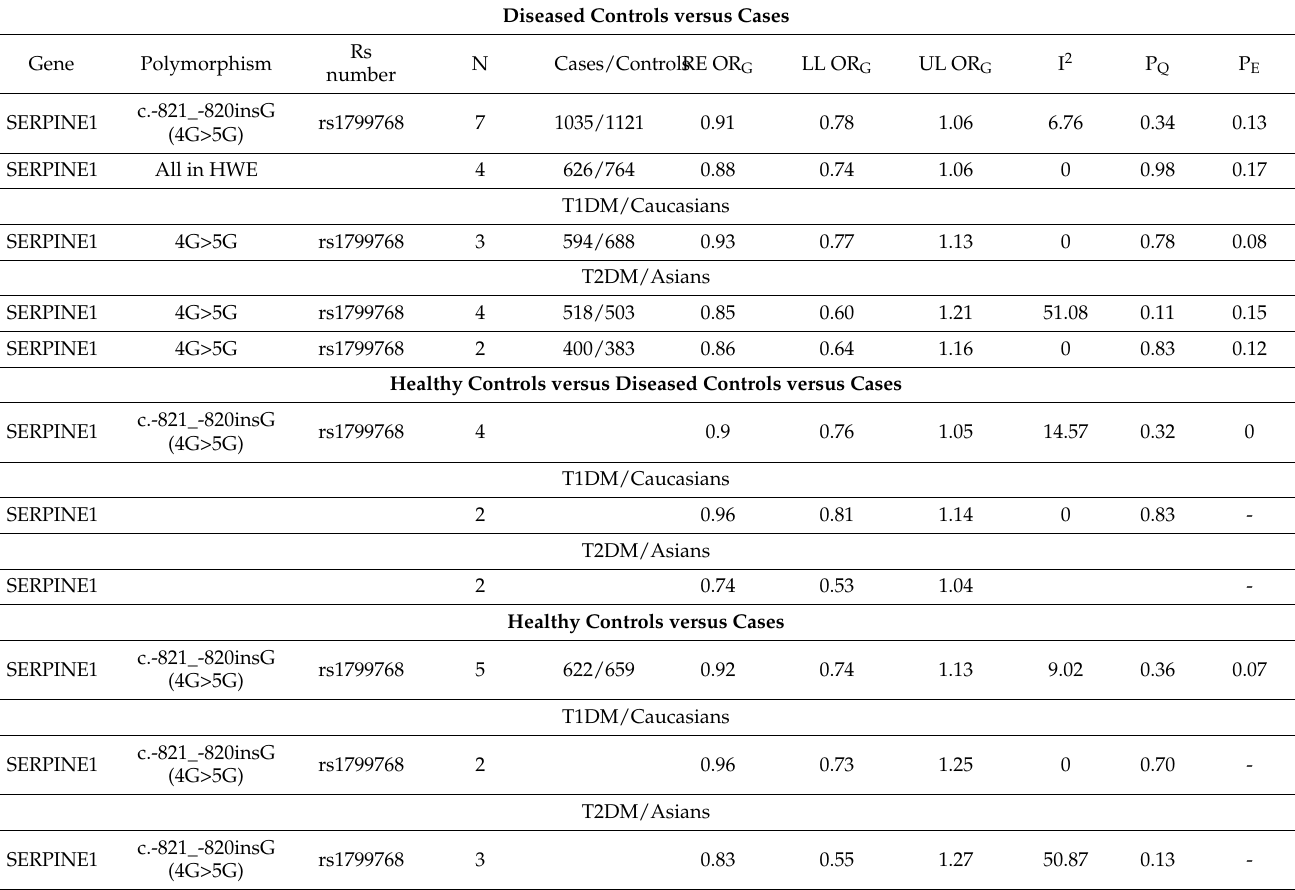
Table 5. Statistically significant results from meta-analysis of 4G/5G